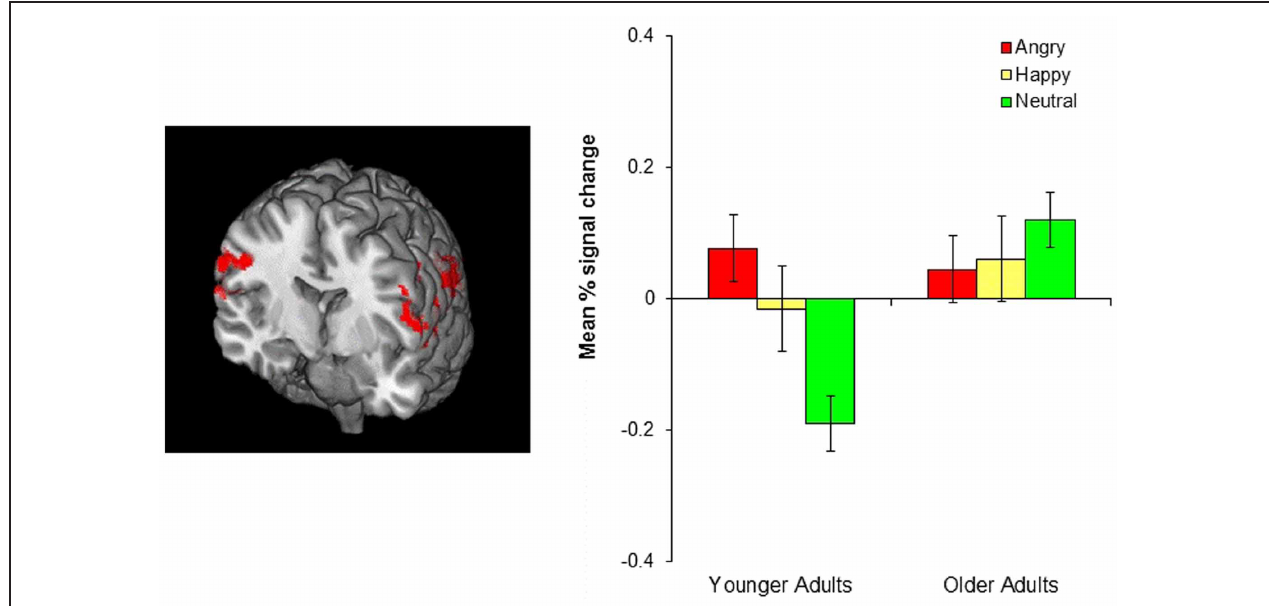
FIGURE 4 | The left image shows age-related differences in the parietal cortex in the neutral condition. Older adults showed greater parietal cortex activity than did younger adults. The image was threshholded at the whole-brain level using clusters determined by z > 2 . 3 and a (corrected) cluster significance threshold of p = 0 . 05. The